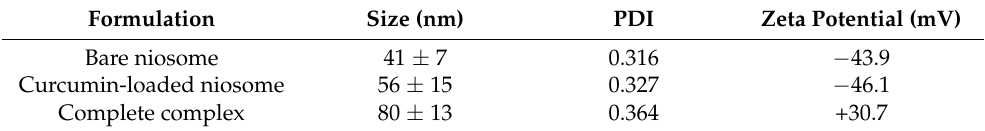
Table 1. Average size (based on the number average), polydispersity index, and zeta potential of niosomes (with and without curcumin) and polymer-coated niosomes with two different drugs. Formulation Size (nm) PDI Zeta Potential (mV) Bare niosome 41 ± 7 0.316 − 43.9 Curcumin-loaded niosome 56 ± 15 0.327 Complete complex 80 ± 13